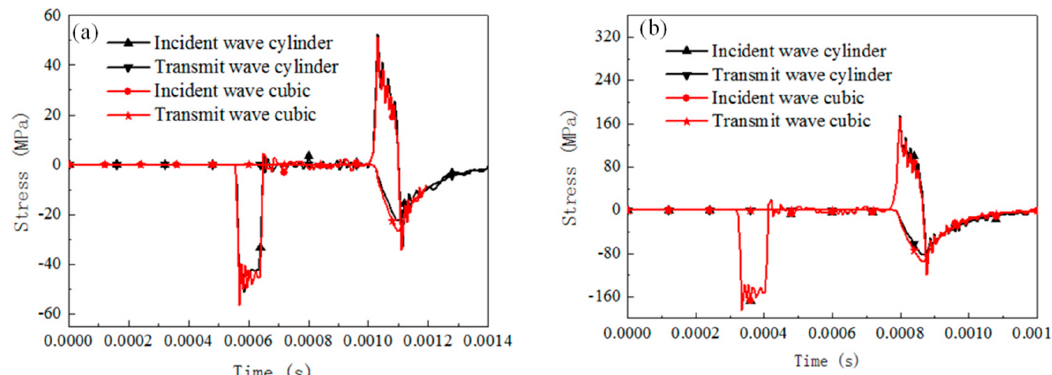
Figure 8. Comparison of the reflected and transmitted waves for cylinder specimen and cubic specimen with rate-independent material (u = 0). ( a ) Impact velocity of 3 m/s, ( b ) impact velocity of 10 m/s.